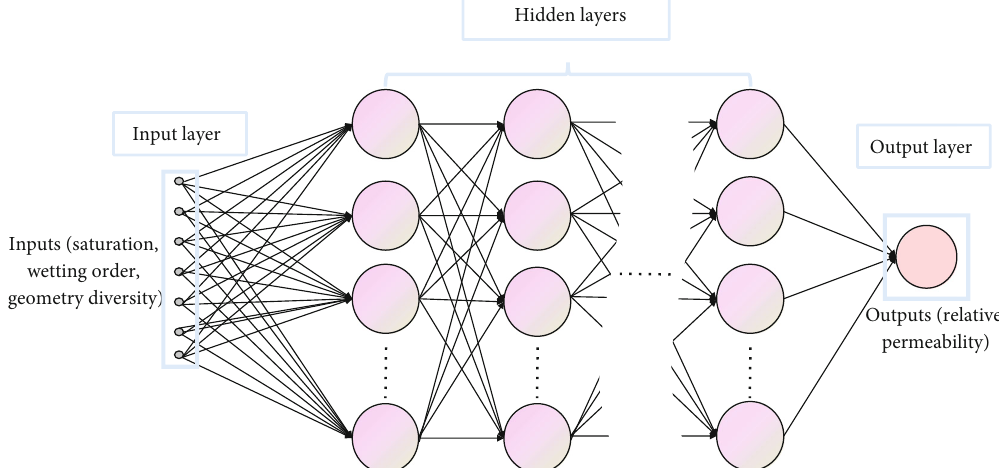
Figure 5: Schematic diagram of the deep neural network (DNN) for two-phase relative permeability